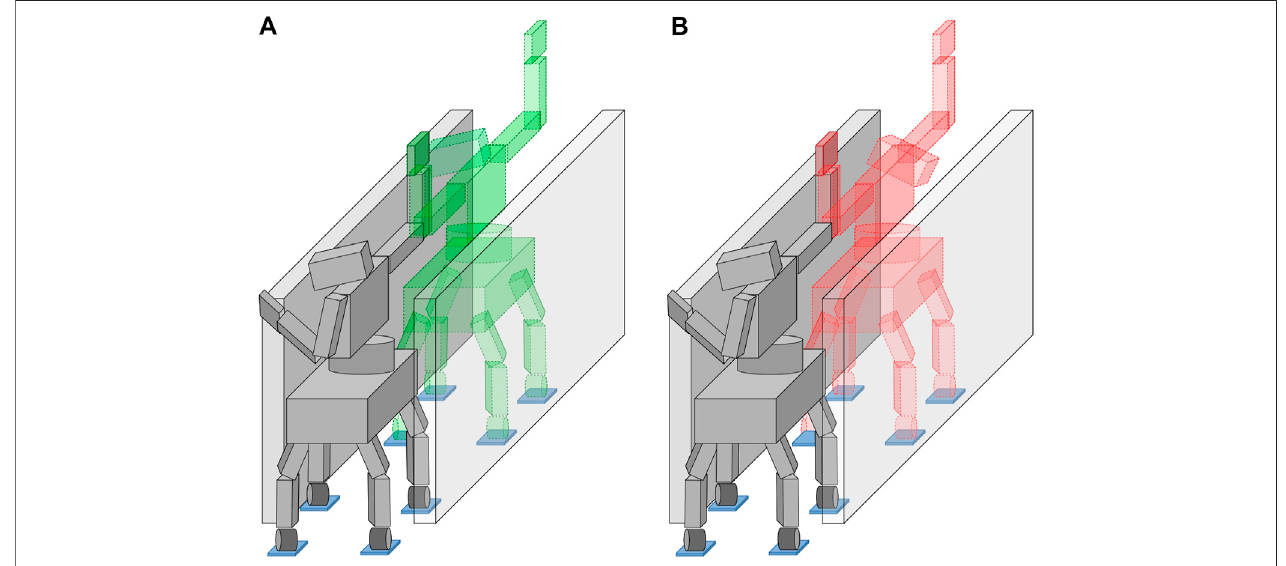
FIGURE3| Anexample ofhowgeneratingadjacent poseswithlargedifferencescanleadtoanunfeasiblecollidingtransitionduringtheirconnection.Startingfrom thesamerobotcon fi gurationingray,thenextpostureisgeneratedminimizingthedifferencesw.r.t.theparentstate,ontheleft,orfacingtheoppositesideofthecorridor withtheupperbody,ontheright.Eventhoughallthegeneratedposesarefeasible,therightscenariowillleadtoacollisionwiththeenvironmentwhileconnectingthetwo consecutive states.